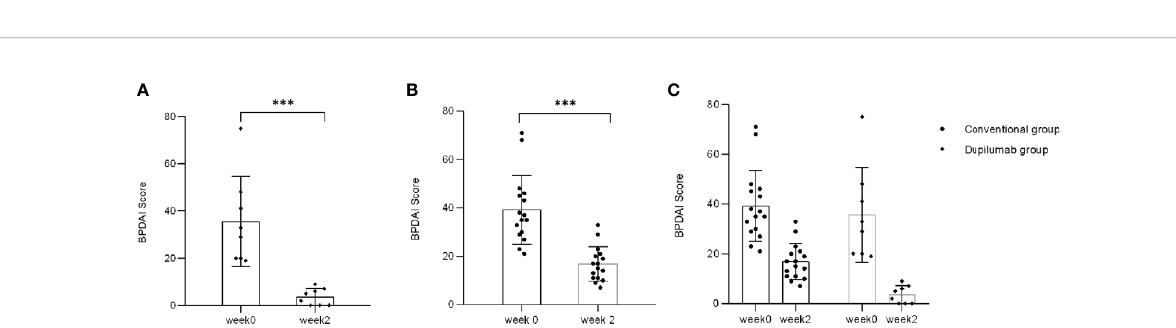
FIGURE 3 | Comparison of NRS score between two treatment groups. NRS score has decreased to varying degrees from weeks 0 to 2 in the dupilumab group (A) (*** p < 0.001 by Mann-Whitney U test), and the conventional group (B) (*** p < 0.001 by Mann-Whitney U test). (C) Patients in dupilumab group showed more privileges in relieving itch ( p = 0.034 by two-way RM ANOVA).